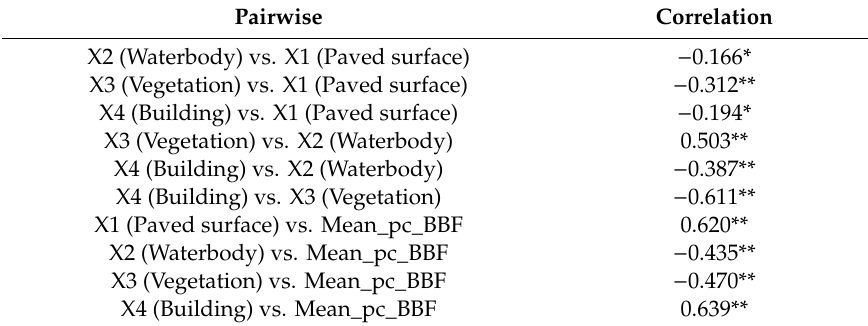
Table 2. Coefficients of Pearson’s product-moment correlations. Table 2. Coe ffi cients of Pearson’s product-moment correlations. Pairwise Correlation Pairwise Correlation